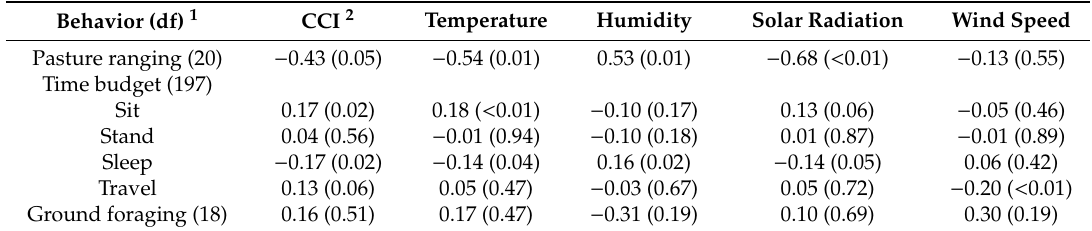
Table 2. Spearman’s rank correlation coefficients and p -values for relationships between broiler pasture ranging, time budget behaviors, and ground foraging with climatic conditions.